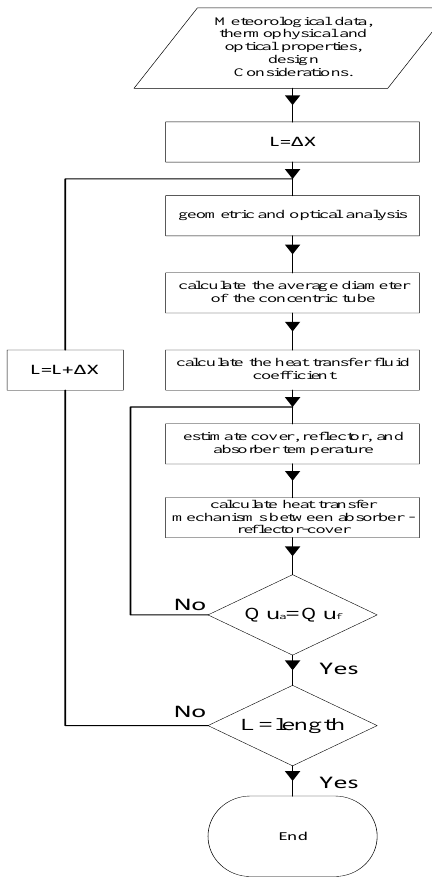
Figure 6. CPC solar collector simulation algorithm. The simulated system is shown in Figure 7 .